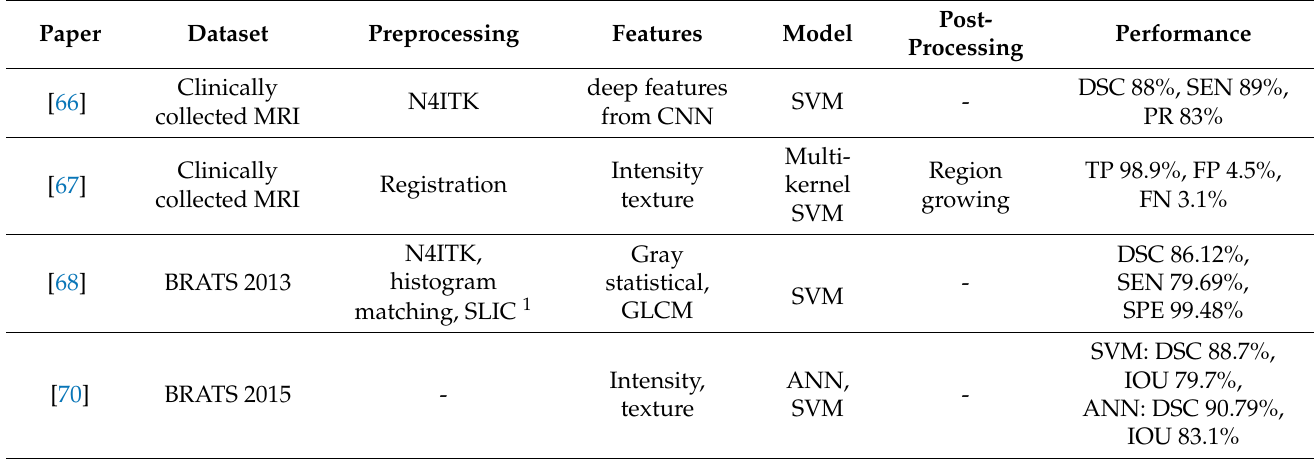
Table 4. Summary of a shallow machine learning based